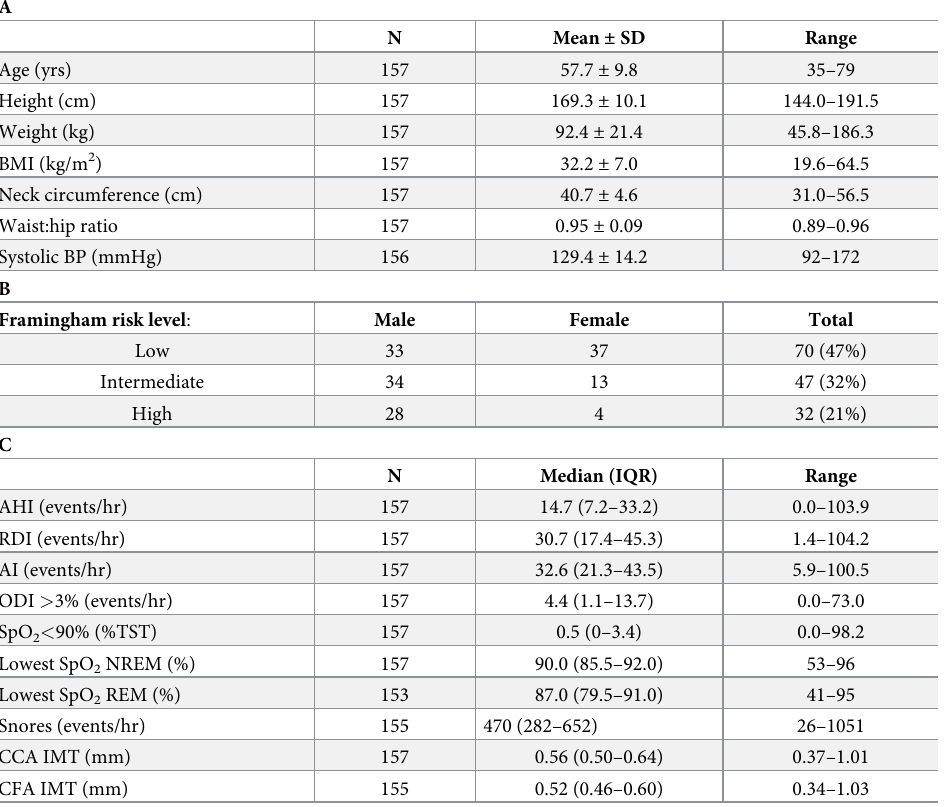
Table 2. RFM sub-group demographics and sleep disordered breathing status. Demographics (A), cardiovascular risk (B), IMT and SDB status (C) of the RF Minimisation Sub-Group, presented as mean ± SD, median (IQR) or fre- quency, where appropriate, plus range. See text for